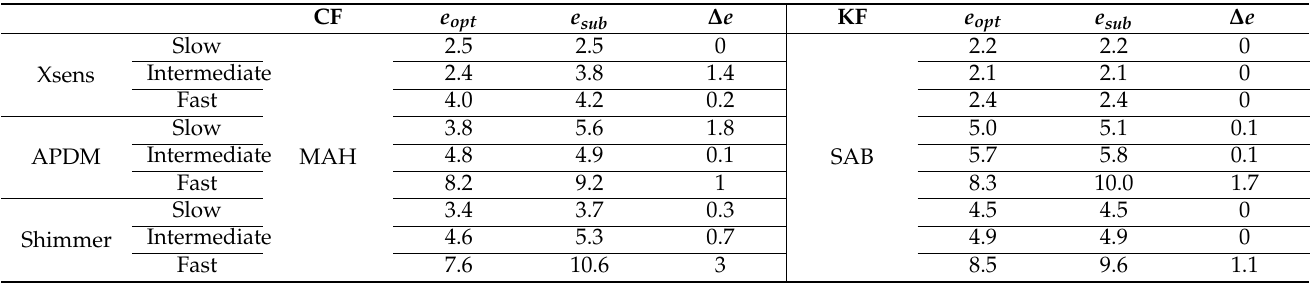
Table 4. The optimal and suboptimal errors are reported together with their residual for each SFA and for each experimental scenario. The residual values higher than 0.5 deg are highlighted in